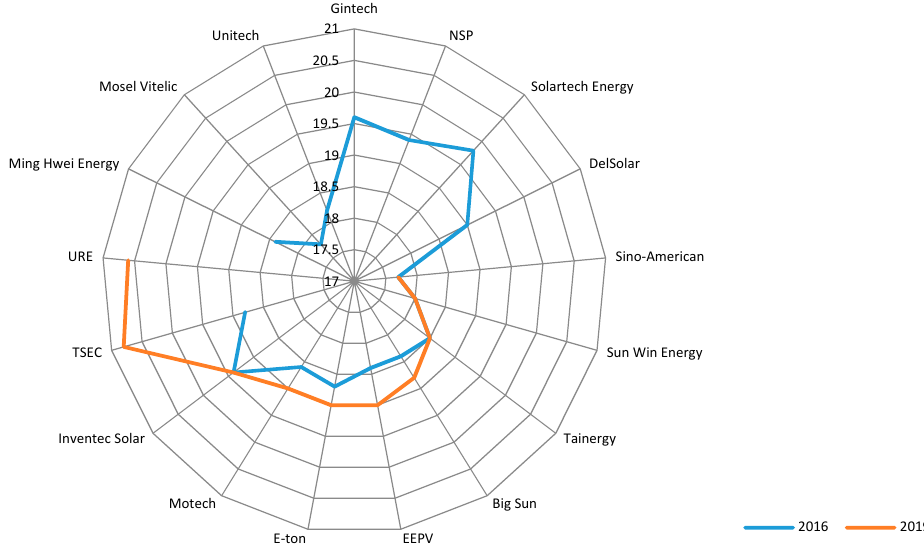
Figure 12. c-Si poly cell e ffi ciency (%) of Taiwanese manufacturers within the